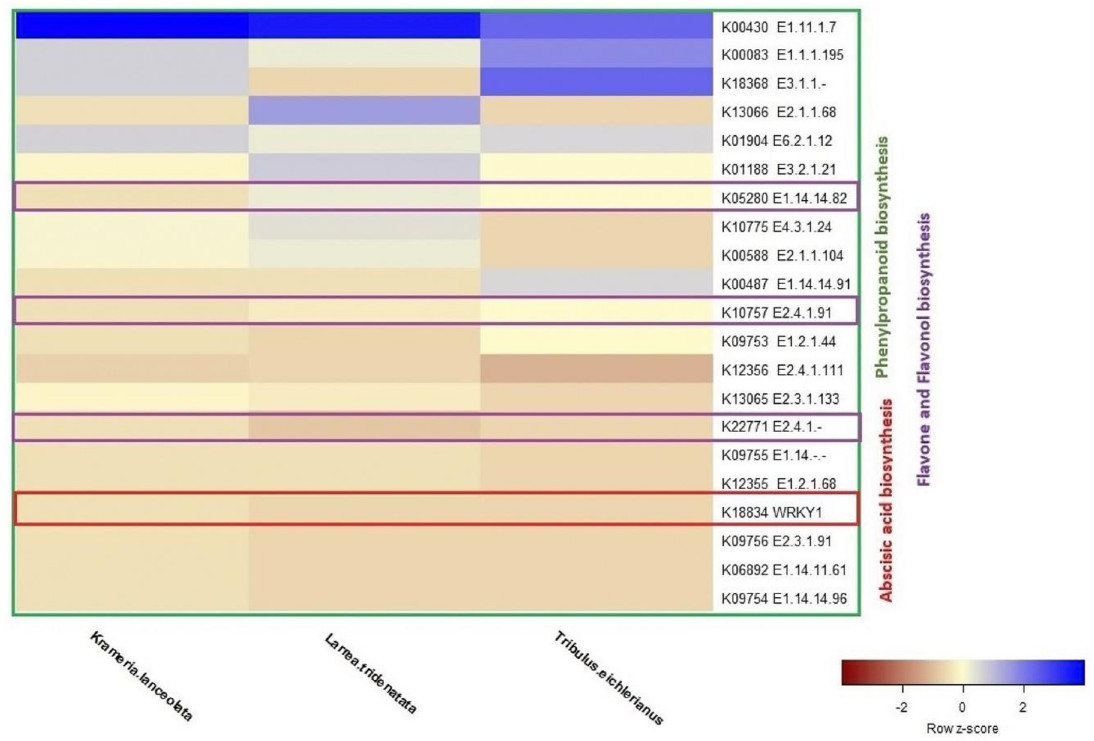
Fig 7. The heatmap showing distribution of L . tridentata genes involved in phenylpropanoid biosynthesis, flavone biosynthesis, and abscisic acid production pathway classified into KEGG Orthology terms compared with those in K . lanceolata and T . eichlerianus .